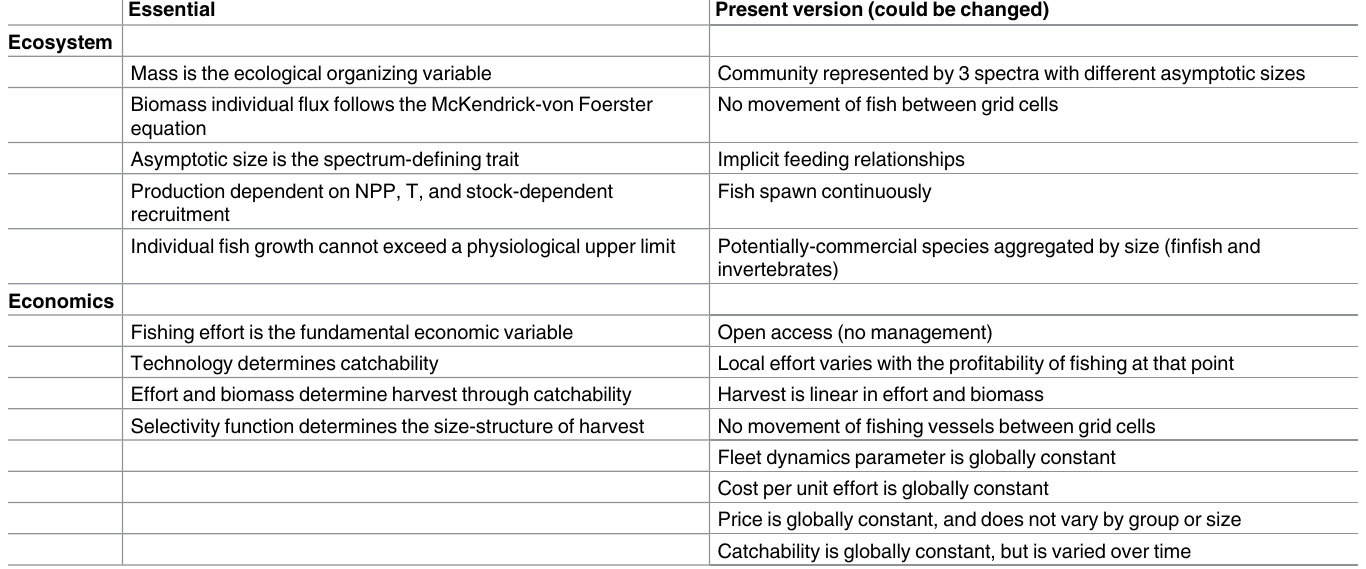
Table 1. Key model